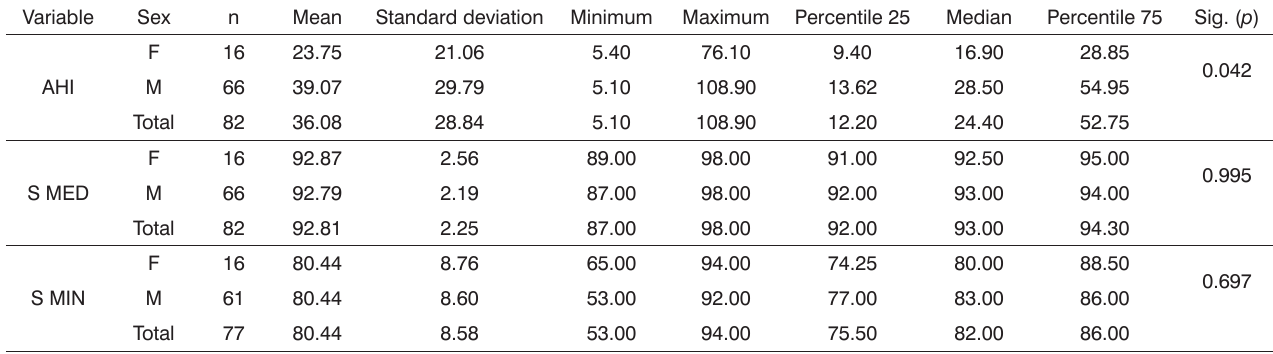
Table 3. Comparison among sex and polysomnography parameters.